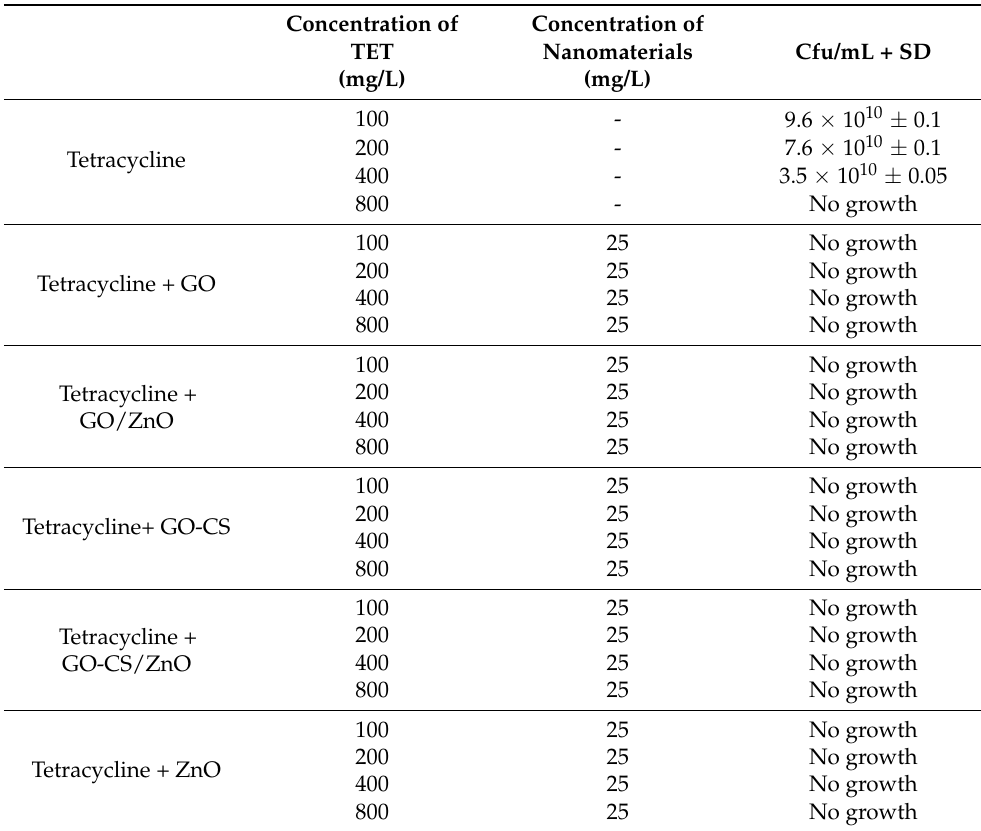
Table 3. Drug ability study of nanomaterials (GO, GO/ZnO, GO–CS, GO–CS/ZnO, and ZnO).